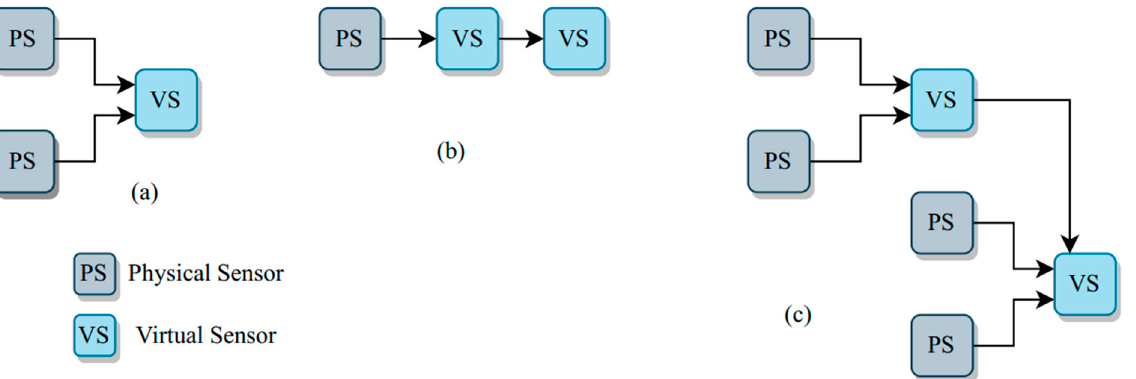
Figure 2. Three virtual sensor (VS) constellations: ( a ) VS based entirely on physical sensor (PS), ( b ) VS based only another VS and ( c ) VS based on both virtual and physical sensors [32]. Virtual sensor intercorrelates with data captured by physical sensors which are embedded into software applications to implement the algorithmic analytics from all the data sets given.